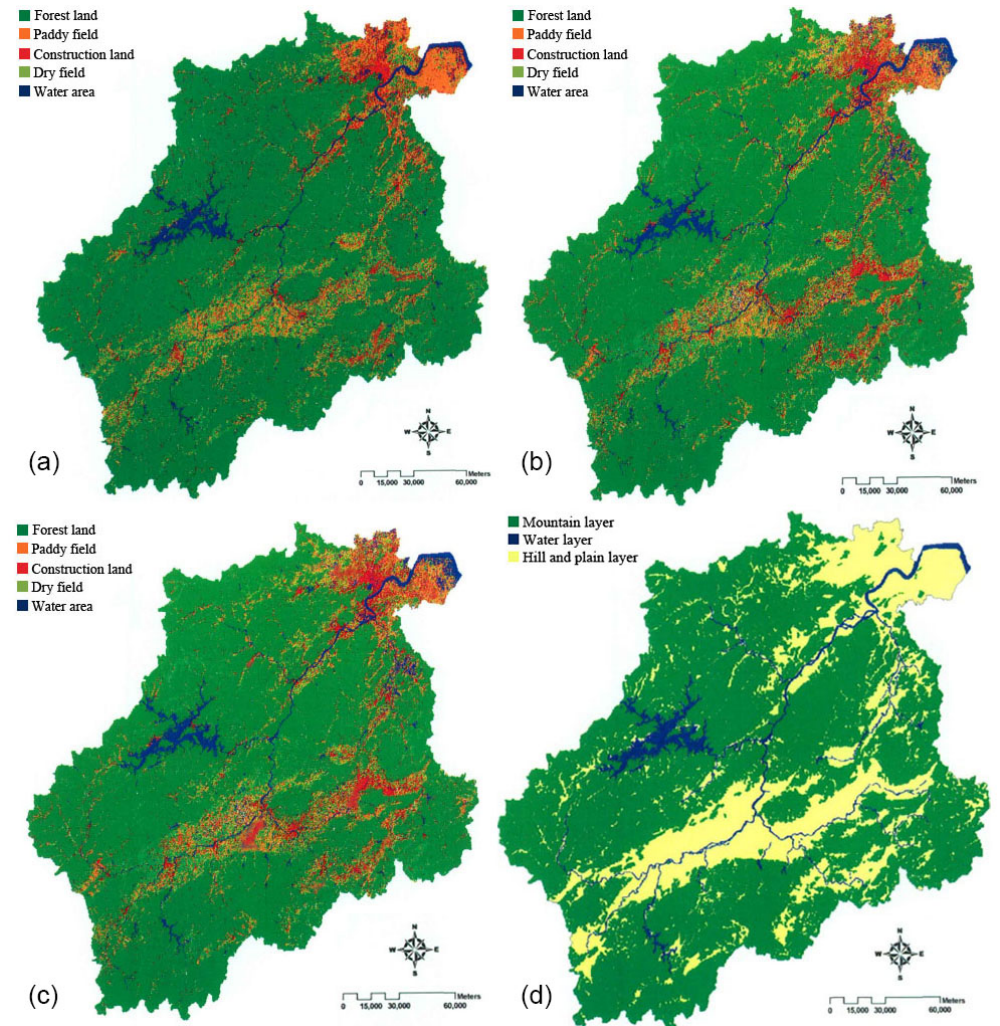
Figure 2. Map of the Qiantang River basin and spectral angle mapping based automatic classification of land use and cover of the Qiantang River basin in year 2001, 2007 and